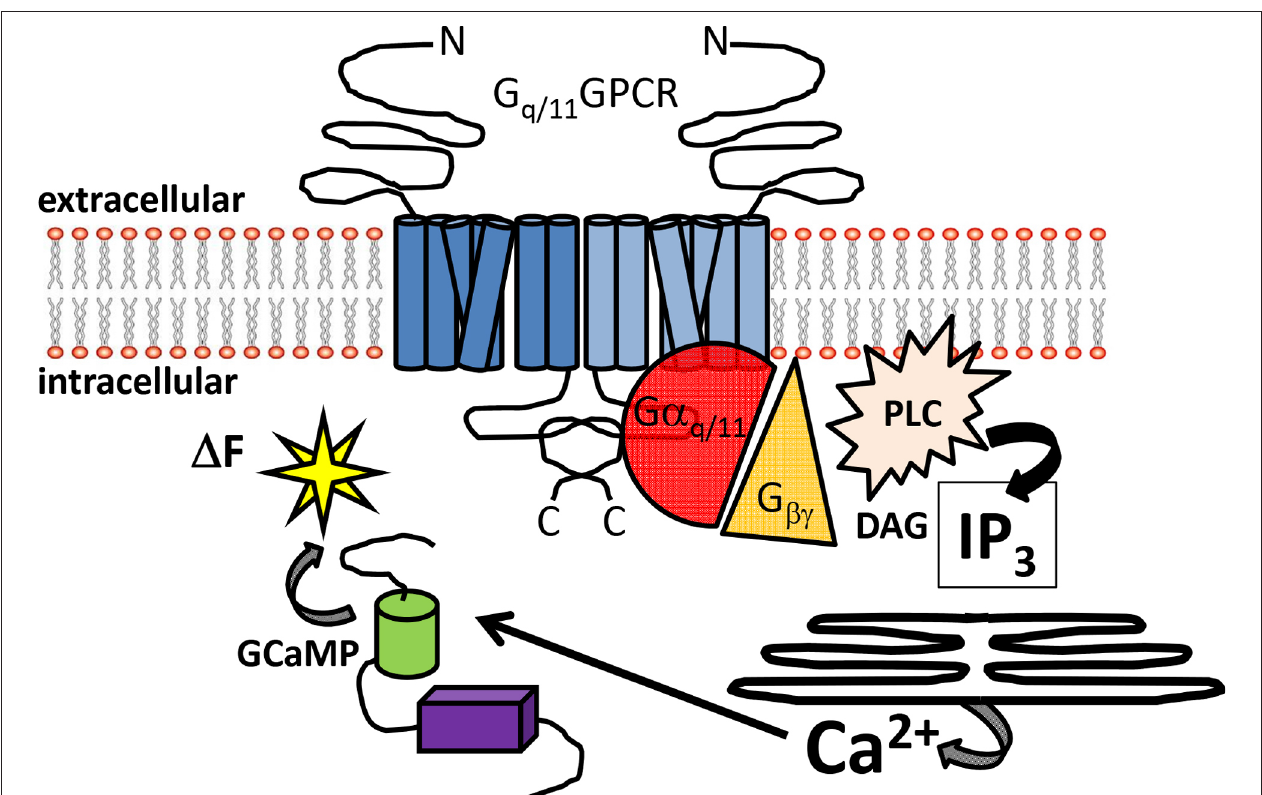
from PLC activation, gating of IP 3 receptors embedded in the ER and release of intracellular Ca 2 + stores. Free Ca 2 + can then bind to GCaMP sensors in the cytoplasm, resulting in enhanced fluorescence. Abbreviations: N: amino-terminus C: carboxy-terminus; PLC: phospholipase C; DAG: diacylglycerol, IP 3 : inositol trisphosphate; (cid:49) F: change in